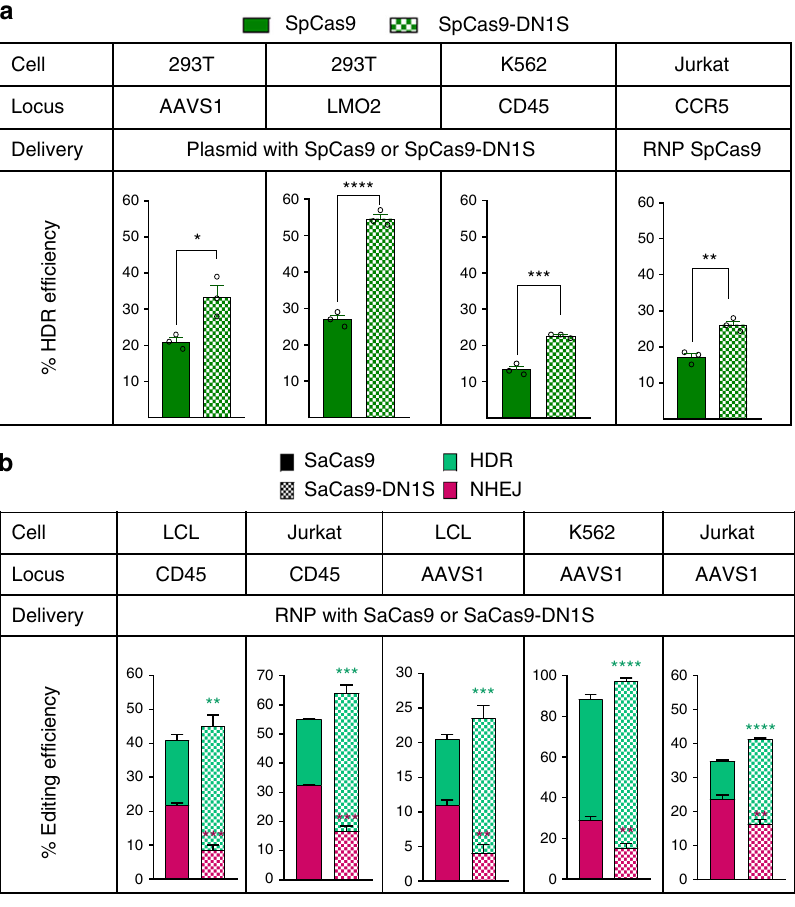
Fig. 3 Cas9-DN1S stimulates HDR at different target genes in multiple cell lines. a Bar plots showing the HDR editing ef fi ciency of SpCas9 or SpCas9-DN1S at the AAVS1 and LMO2 loci in 293T cells, the CD45 locus in K562 cells, and the CCR5 locus in Jurkat cells. SpCas9 or SpCas9-DN1S and the donor templates were delivered through the plasmid system in 293T and K562 cells. SpCas9 or SpCas9-DN1S were delivered by ribonucleoprotein (RNP) and the three independent electroporations. Black circles indicate individual data points. Statistics: Unpaired t tests, one tailed. * P < 0.05, ** p < 0.01, *** p < 0.001, and **** p < 0.0001. b Stacked bar plots showing the NHEJ and HDR editing ef fi ciency of SaCas9 or SaCas9-DN1S at the CD45 and AAVS1 loci in LCL